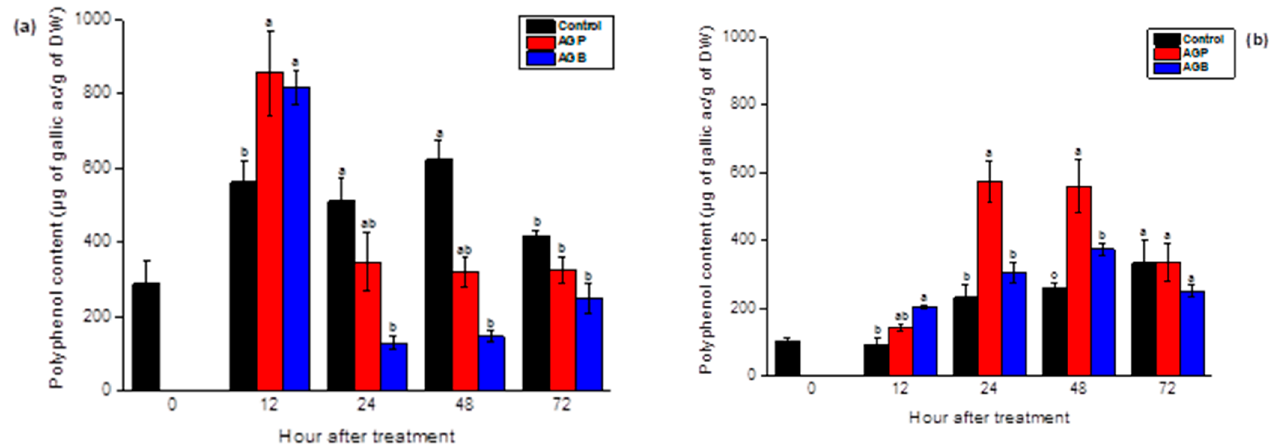
Figure 7. Accumulation of phenolic compounds in the leaves ( a ) and the roots ( b ) of tomato seedlings after foliar spray (20 mL) of AGB and AGP fractions (1 g/L). Each value is the mean of four repetitions ± SE. The letters (a, b, c) indicate significant differences between treatments (Control, AGB, and AGP) in each point time using the Tukey–HSD test, at ( p < 0.05). Treatments presented with the same letter are not significantly different.